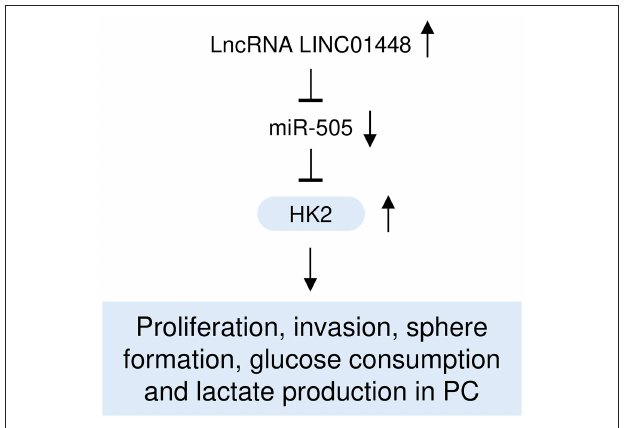
FIGURE 9 | A hypothetical model illustrating that the LINC01448/miR-505/HK2 axis modulates PC glycolysis and